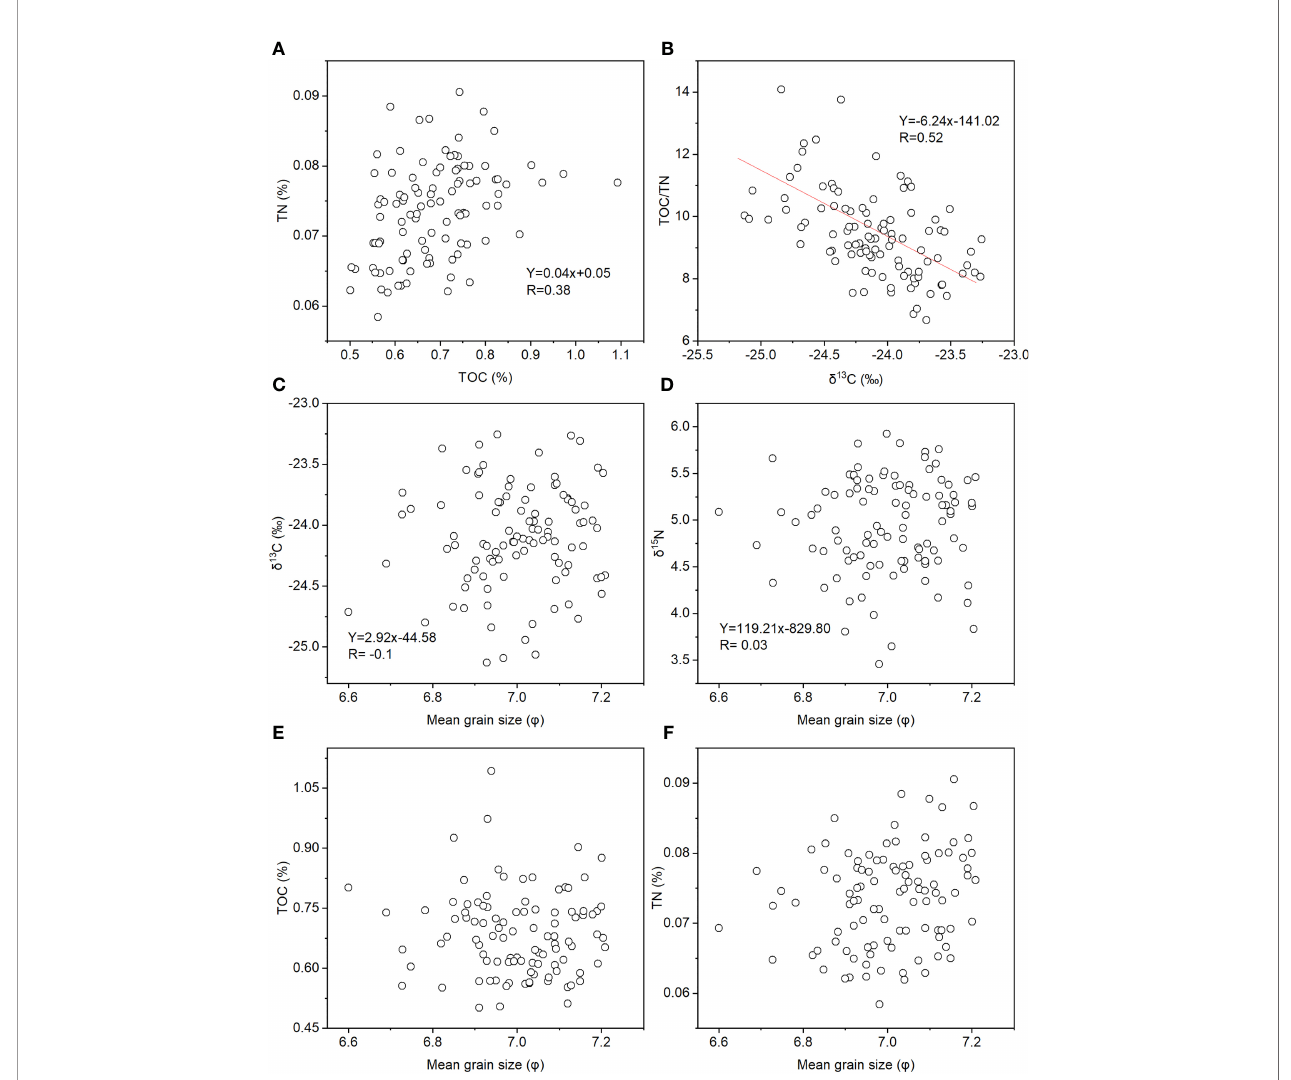
FIGURE 6 | Correlation plots for TOC and TN (A) , TOC and d 13C (B) , d 13C and mean grain size (C) , d 15N and mean grain size (D) , TOC and mean grain size (E) , and TN and mean grain size (F)